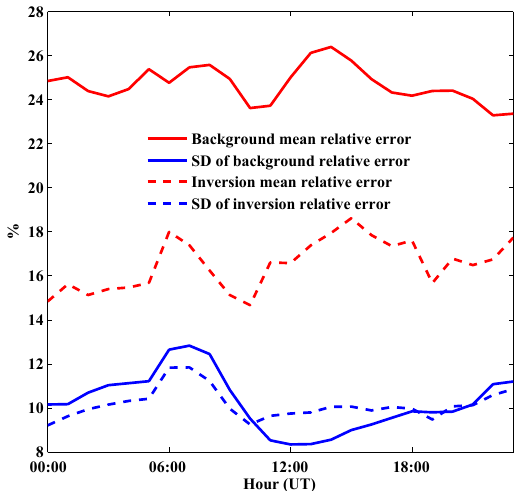
Figure 6. The average relative reconstruction error and standard de- viation using regularization method I under the background II sit- uation. The red solid line is the average relative error of the back- ground electron density. The blue solid line is the standard deviation of the background relative error. The red dashed line is the average relative error of the reconstructed electron density. The blue dashed line is the standard deviation of the reconstructed relative